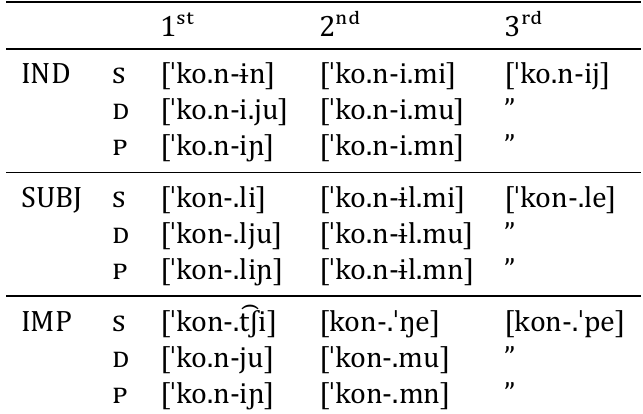
Table 8: Verbal paradigm for the consonant-(cid:976)inal root [kon-] ‘enter’ in Valdivia (1606)